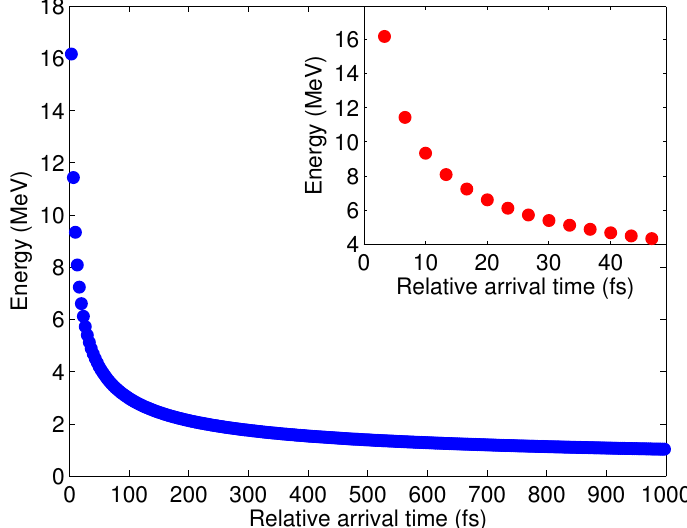
Figure 3. Diagnostics calibration for time of flight measurements. Each point corresponds to one delay line step (3 fs). The inset shows a magnification of the first part (higher energies)